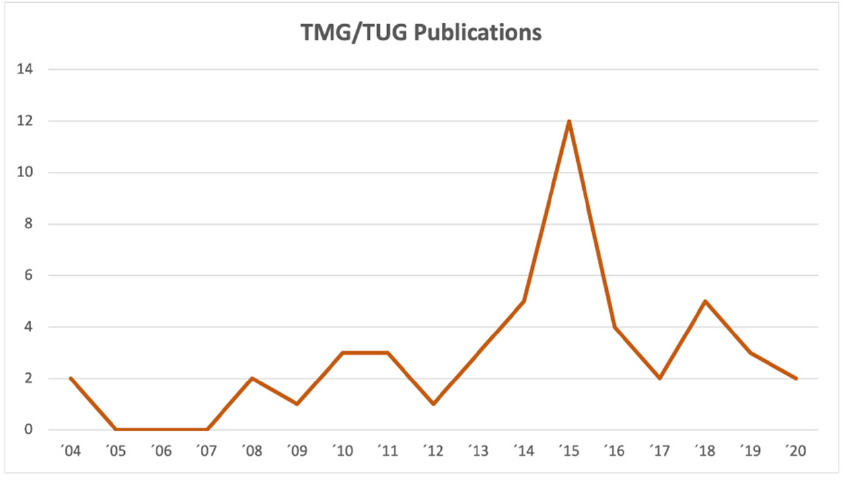
Figure 8. Transverse myocutaneous gracilis (TMG) flap publication trends between 2004 and